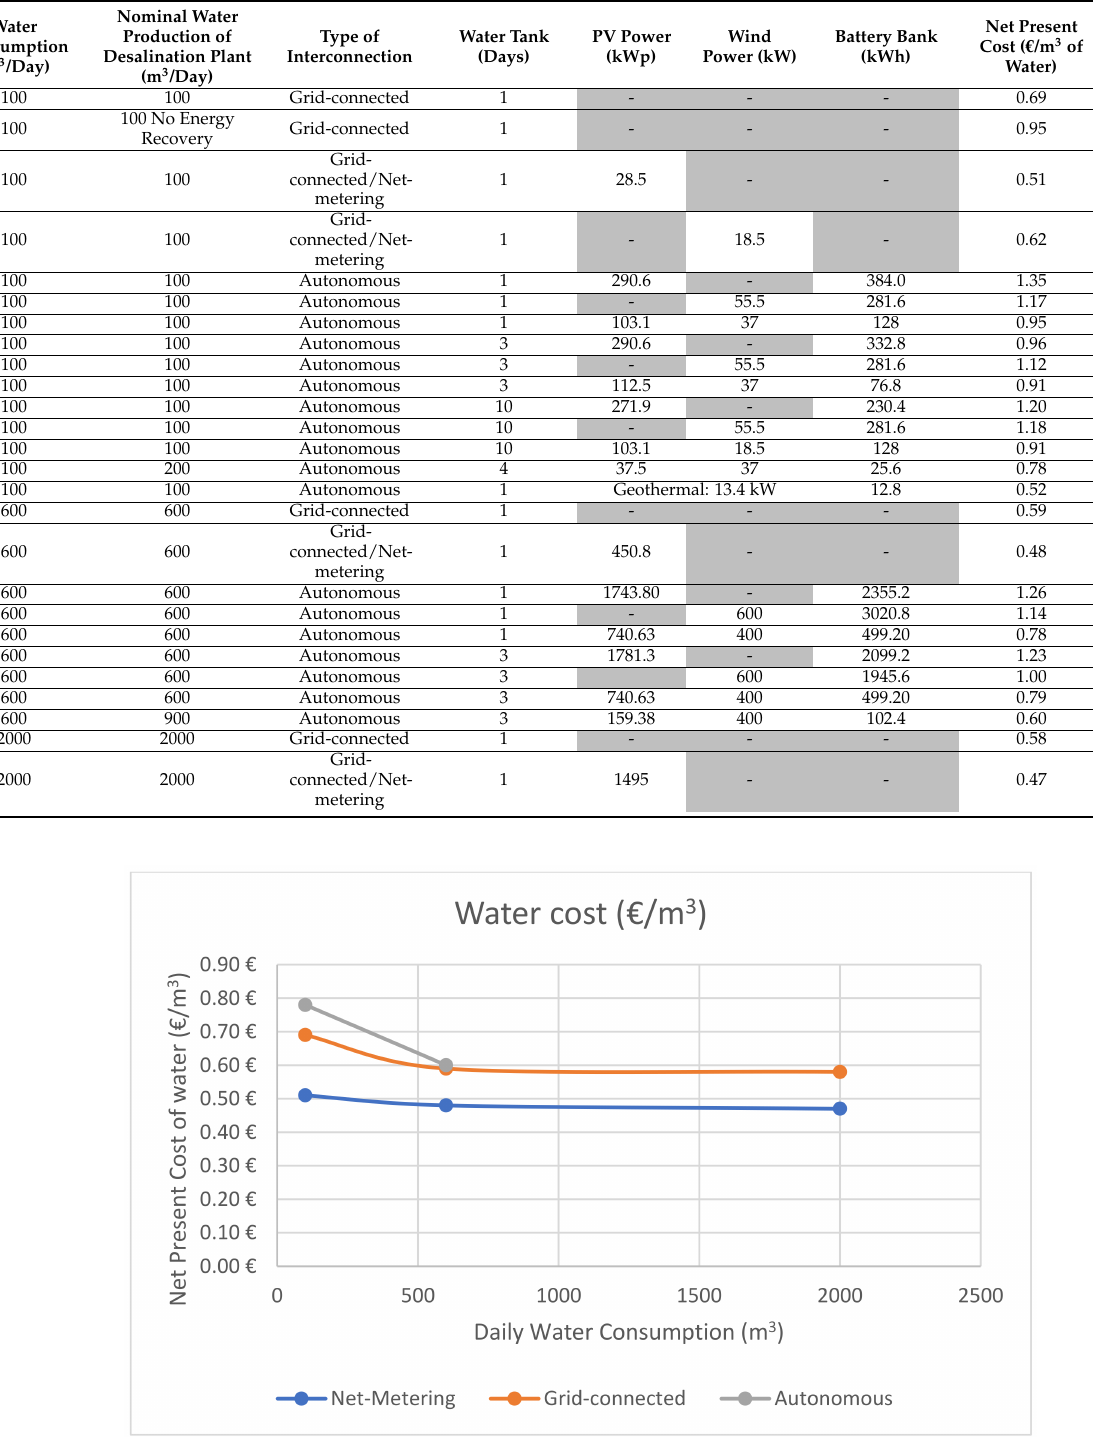
Figure 5. Water cost (excl.